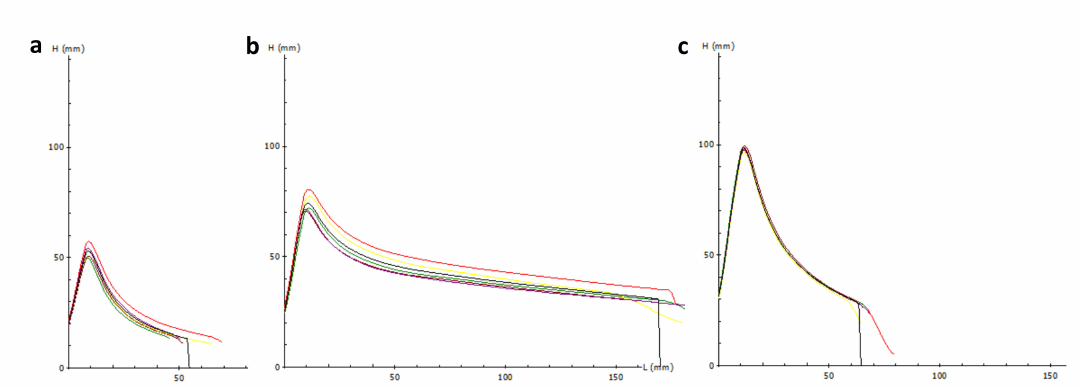
Figure 4. Alveograph profiles of XY7 ( a ), N11 XY7 ( b ), and ( c ) N11 relative to the 2017–2018 growing season. The colored curves indicate technical